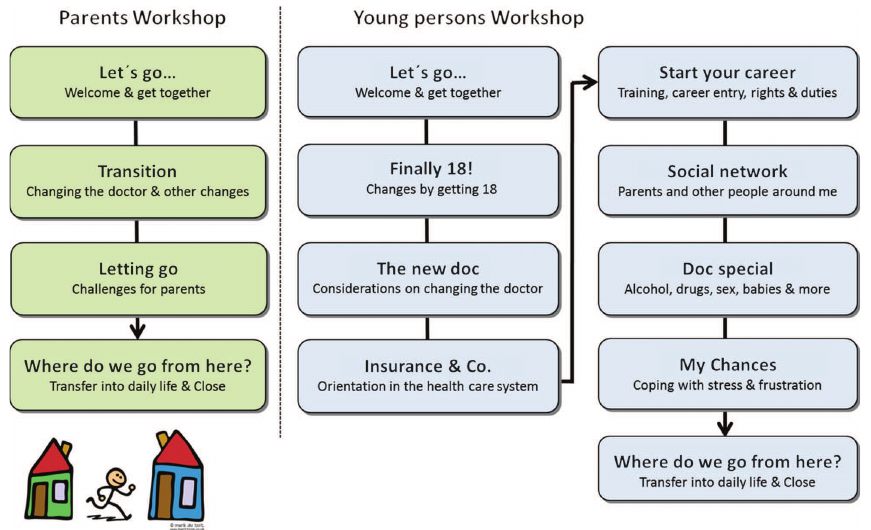
Figure 1: Components of the transition patient education program